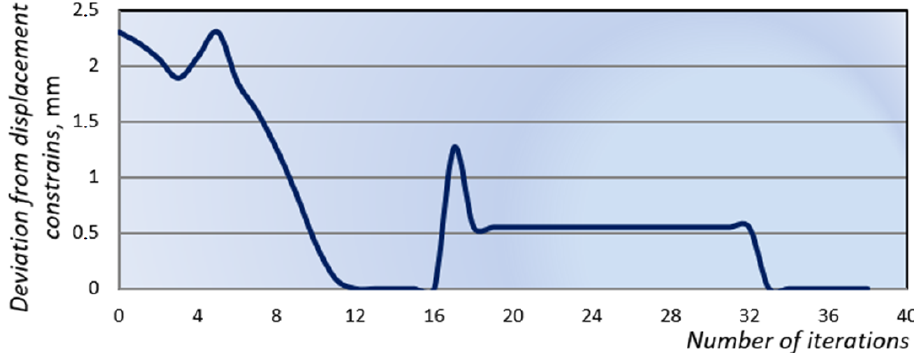
Figure 15. Changes of optimization parameters.